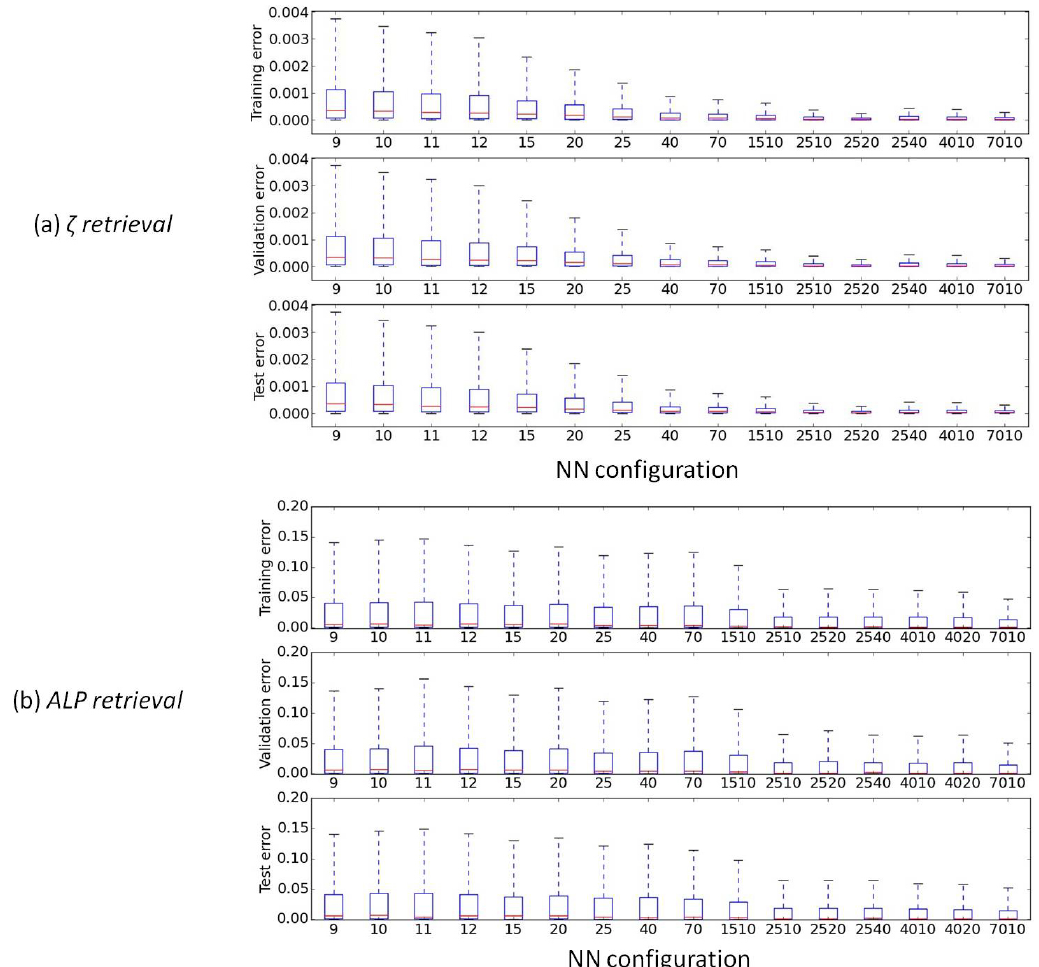
Figure 3. Box–whisker plots of the square of errors (see Eq. 7) obtained for different neural network (NN) configurations, at the end of their training, over the supervised data set (training validation test). The NNs XX have one hidden layer, where XX indicate the number of neurons. The NNs YYXX have two hidden layers, where YY and XX are the number of neurons in the first and second hidden layer, respectively: (a) NNs for τ retrieval and (b) NNs for ALP retrieval. Note that errors are computed over normalized output and true τ( 550nm ) and ALP values (between − 1 and 1) due to the definition of the sigmoid functions (see Sect.